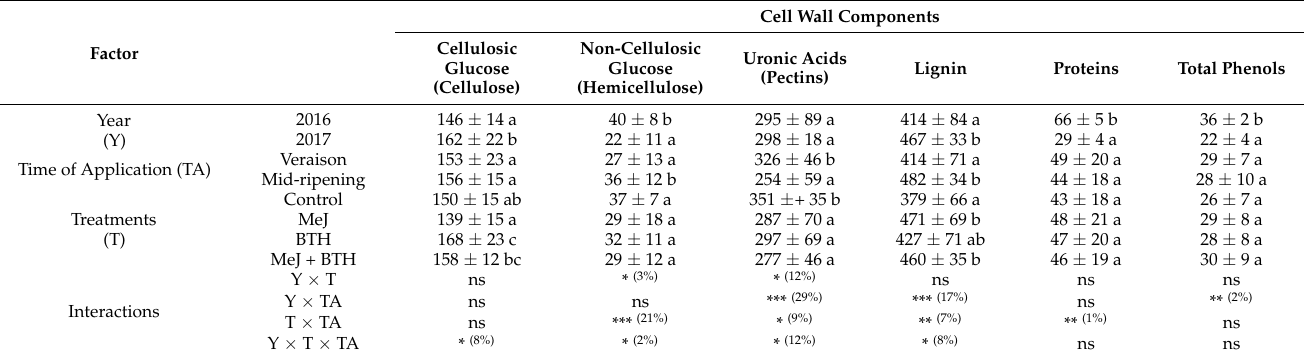
Table 2. Multivariate analysis of SCW components of Monastrell grapes, treated with MeJ, BTH and MeJ + BTH, at two different ripening stages: veraison and mid-ripening, during the 2016 and 2017